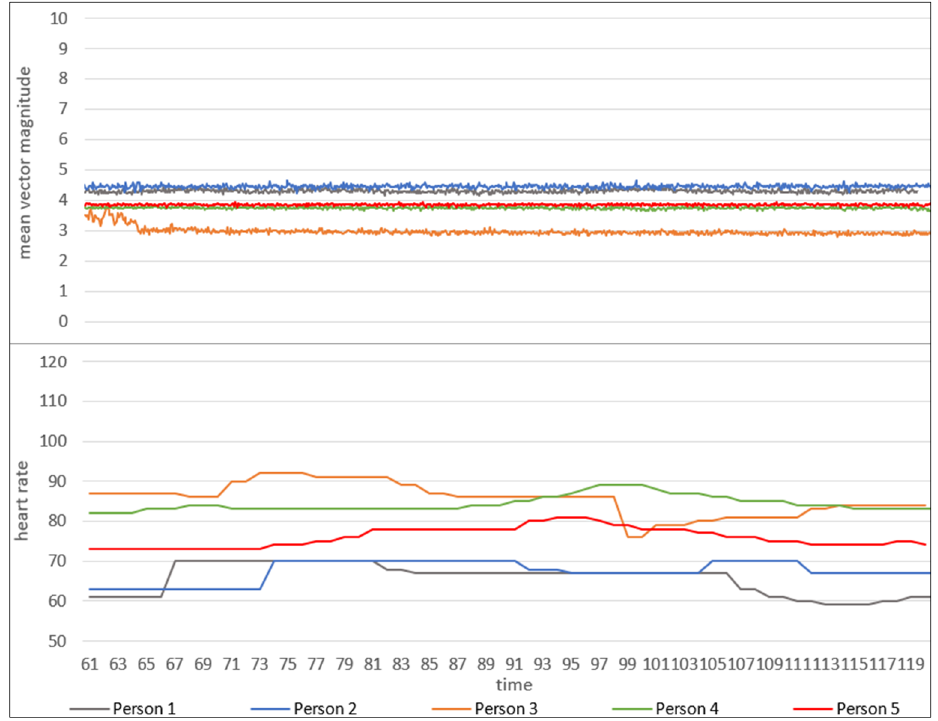
Figure 6. Heart rate and acceleration for the emotional pattern.